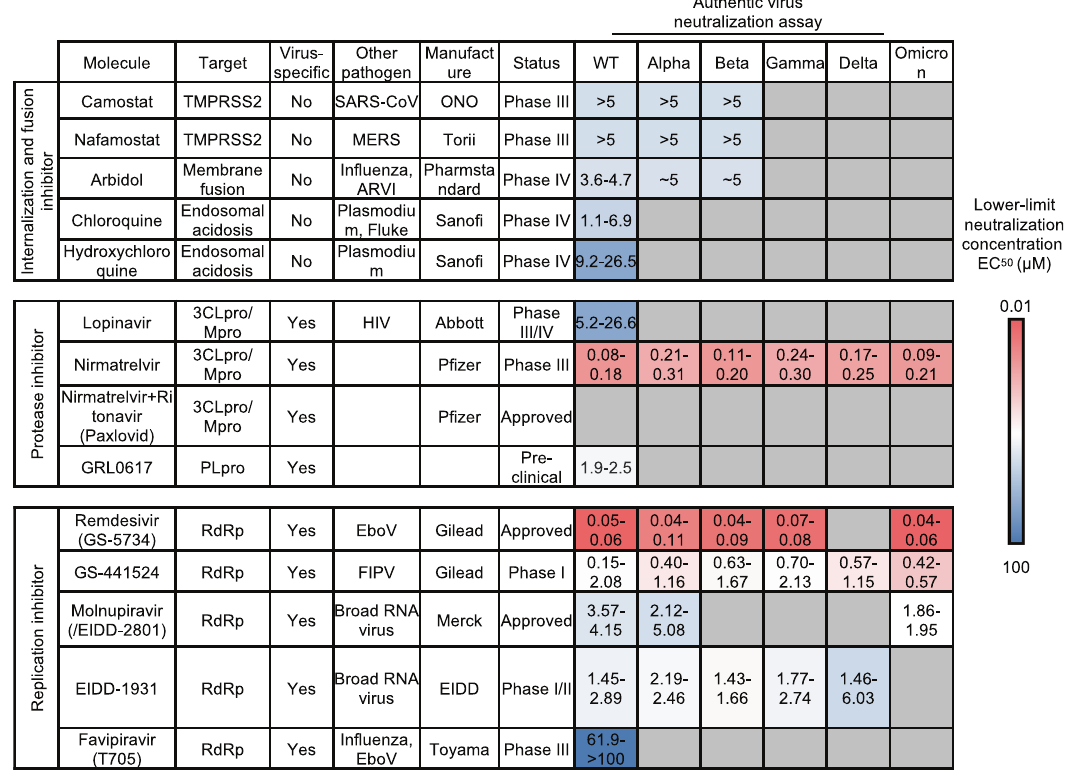
Fig. 8 The summary of neutralization capability of small molecule drugs against in vitro authentic virus infection from SARS-CoV-2 variants. The ranges of neutralization capability of small molecule drugs targeting both viral and non-viral targets against VOCs are listed. The lower- limit concentration EC 50 are indicated in a red-to-blue color scale to represent the minimal neutralizing capability of each antibody reported. A bluer color indicates a stronger evasion of VOCs from neutralization of small molecule drug in comparison to ancestral strain. The detailed small molecule neutralization capability from each study could be referred in Supplementary Table